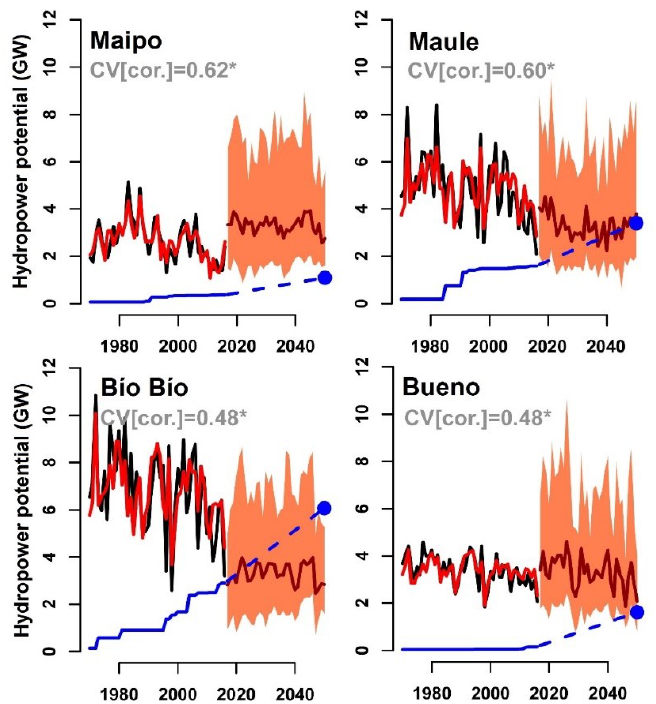
Figure 11. Hydropower potential and installed hydropower capacity in the four study basins in the 1970–2050 period. Black lines show observed hydropower potential. Red lines indicate computed hydropower over the calibration period. Dark red lines and associated coral polygons display the mean, max and min projected hydropower potential using all simulations from 15 GCMs (i.e., 45 simulations). Installed hydropower capacity is displayed as blue lines, while blue dots indicate projected installed hydropower capacity [25,27]. Results of the leave-one-out cross-validation are shown in grey.